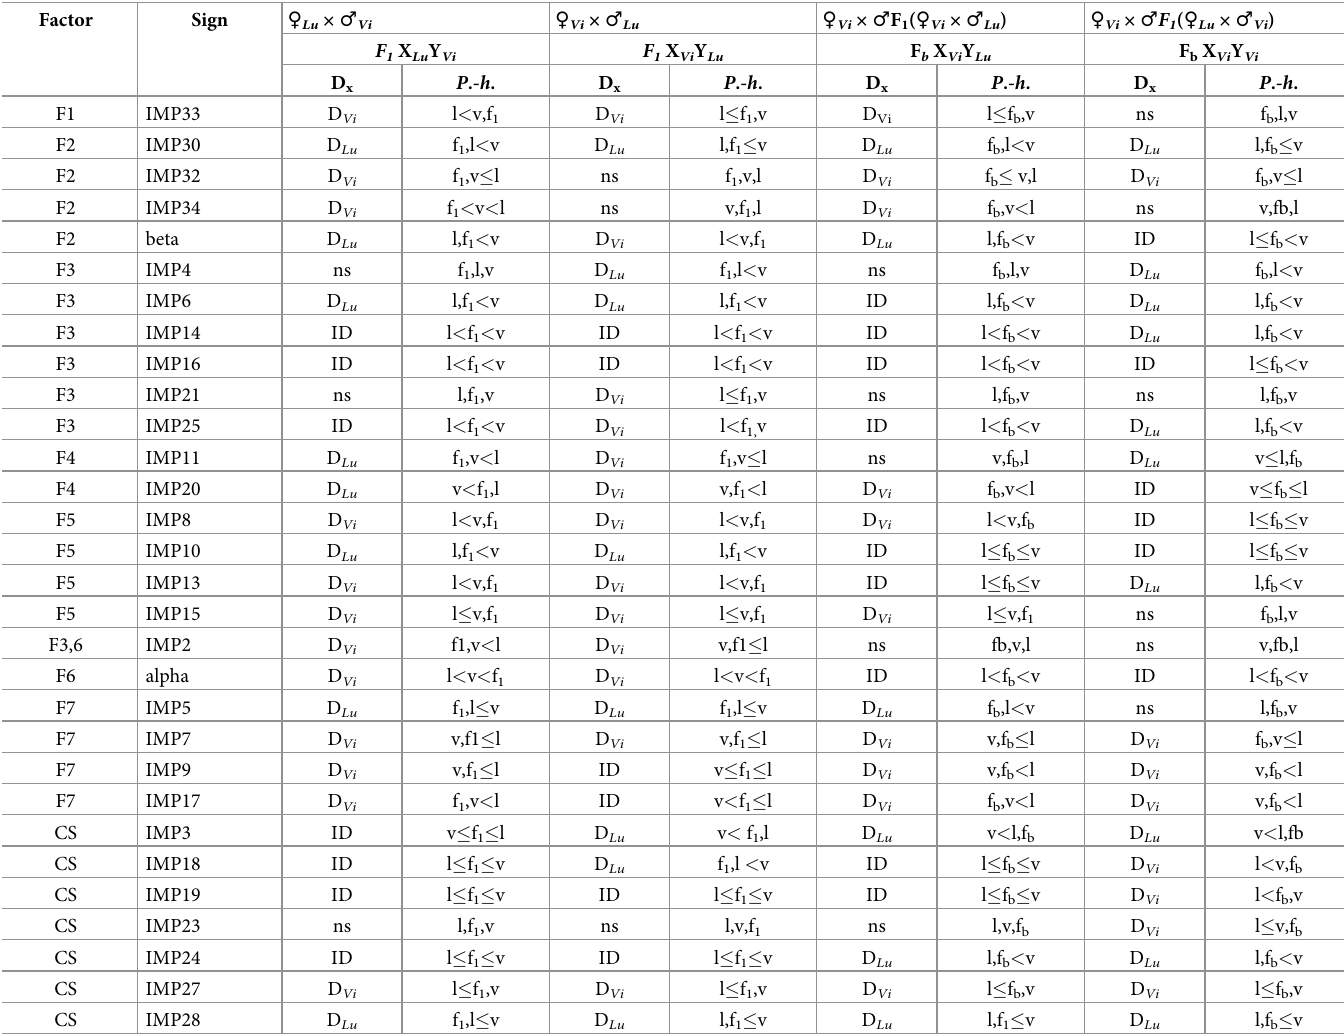
Table 4. The dominance of the copulative system shape-related traits as dependent on the sex chromosome composition in D . virilis / D . lummei hybrid males, het- erozygous for the